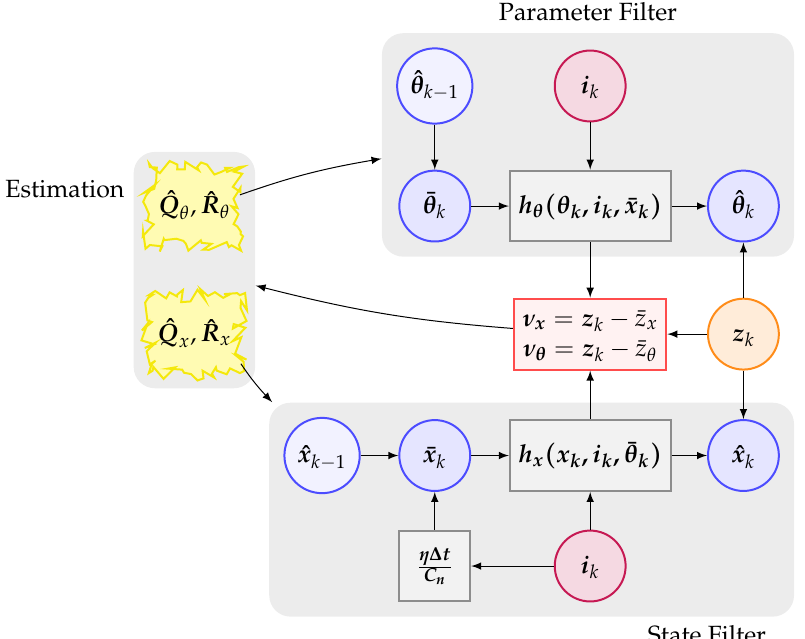
Figure 2. Block diagram of the proposed enhanced